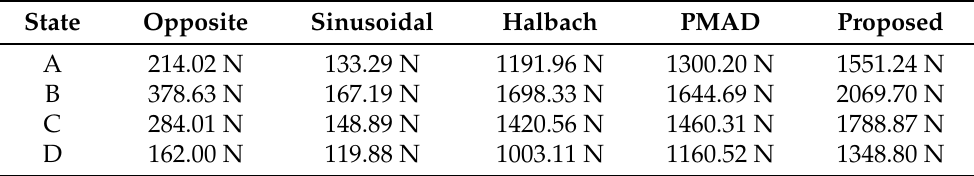
Table 3. Comparison of the adsorption force of the magnetic chuck with the same size and produced different magnetization methods on the adsorption surface under different